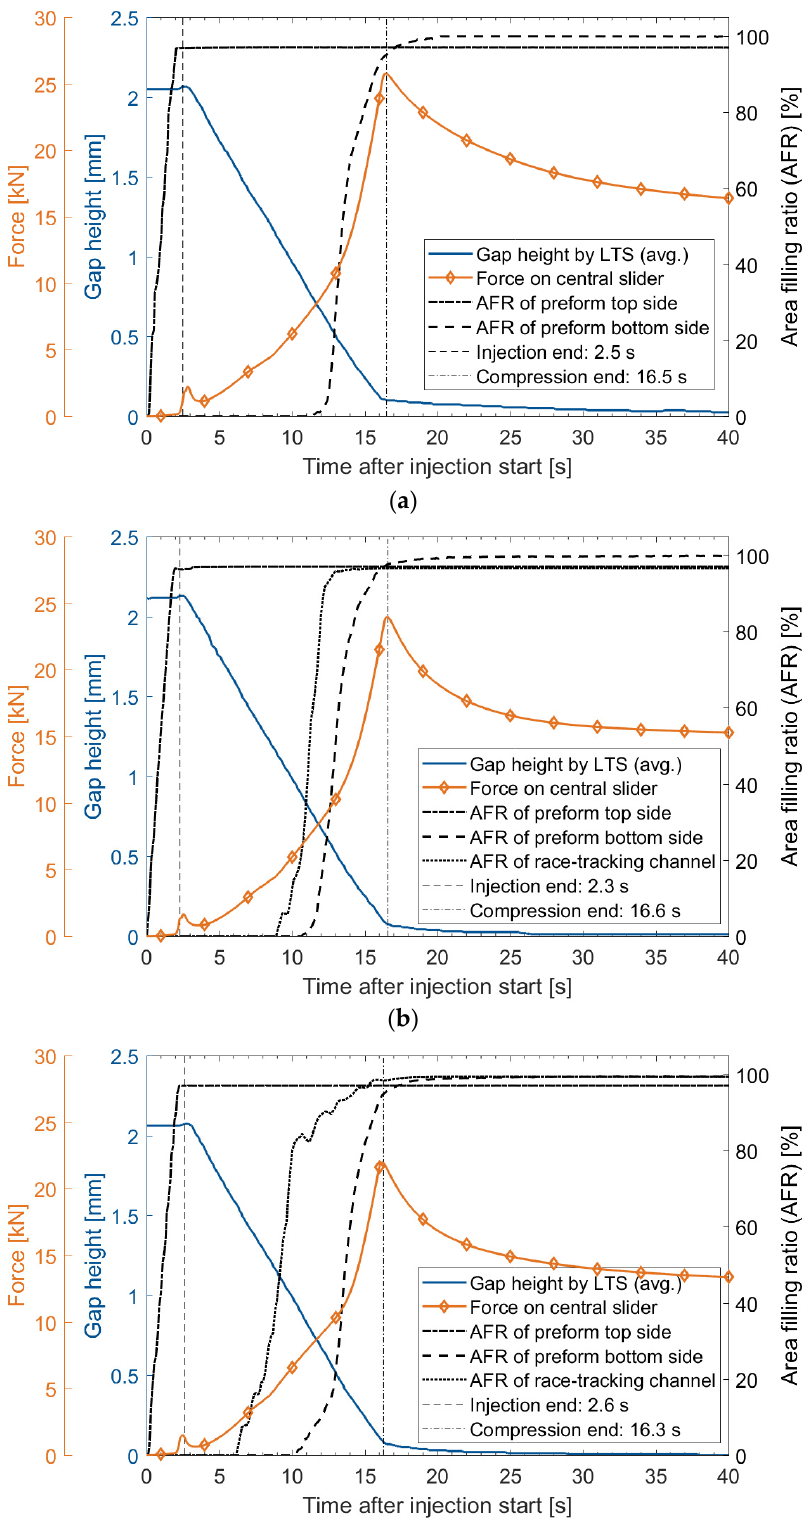
Figure 10. Overview of important process variables during FS-CRTM experiments of the flow control study: ( a ) no race-tracking channel—fcs-#1; ( b ) medium race-tracking channel width—fcs-mrt-#3; ( c ) wide race-tracking channel width—fcs-wrt-#2 (LTS = laser triangulation